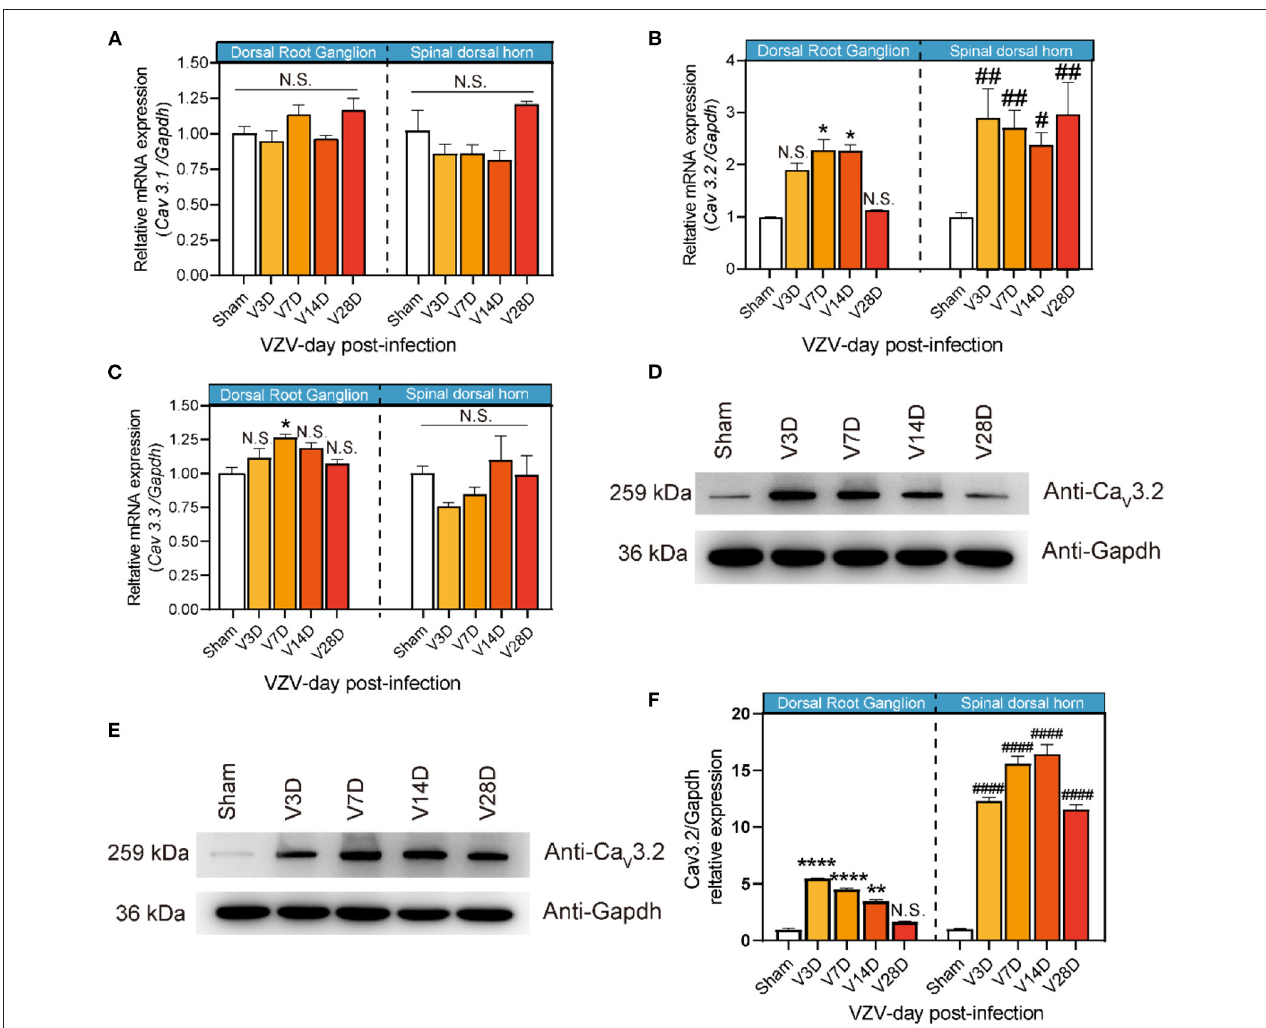
FIGURE 2 | Expression of Cav3.1, Cav3.2, and Cav3.3 in dorsal root ganglion and spinal dorsal horn in sham- and VZV-infected mice. RT-qPCR results of Cav3.1 (A) , Cav3.2 (B) , and Cav3.3 (C) messenger RNA (mRNA) expression in dorsal root ganglion and spinal dorsal horn relative to Gapdh in sham- and VZV-infected mice. Western blot results of Cav3.2 and Gapdh protein expression in dorsal root ganglion (D) and spinal dorsal horn (E) in sham- and VZV-infected mice. (F) Relative quantitative results of Cav3.2/Gapdh protein expression. * p < 0.05, ** p < 0.01, **** p < 0.0001 compared with sham mice in dorsal root ganglion. # p < 0.05, ## p < 0.01, #### p < 0.0001 compared with sham mice in spinal dorsal horn; NS, not significant. V3D, V7D, V14D, and V28D represent days 3, 7, 14, and 28 after VZV inoculation, respectively, n =